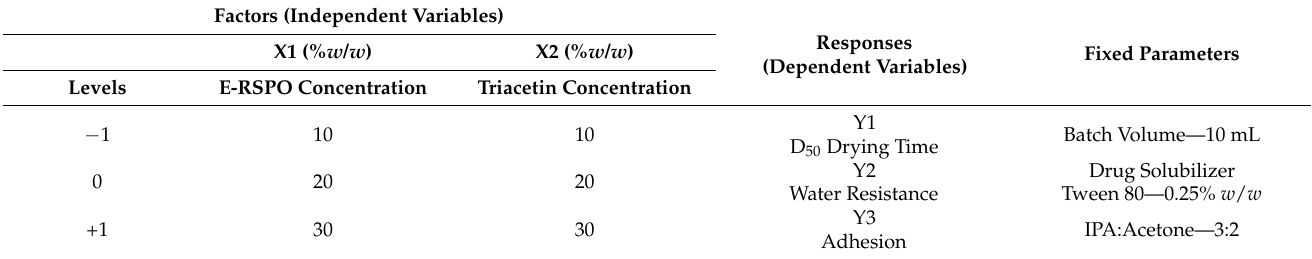
Table 3. Levels of chosen material attributes (X1 and X2) and responses measured (Y1, Y2 and Y3) as well as parameters fixed for the final experimental